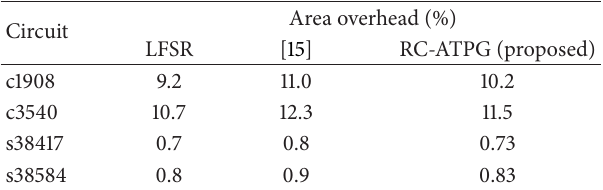
Table 4: Comparison with area